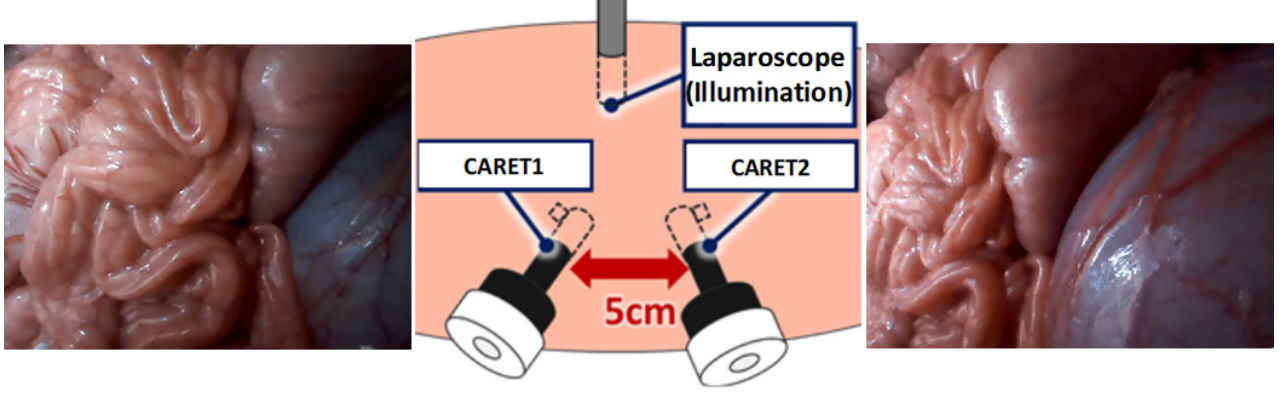
Figure 16. In vivo experimental setup with two CARET devices and a laparoscope as a light source; CARET-1 image on the left side and CARET-2 image on the right